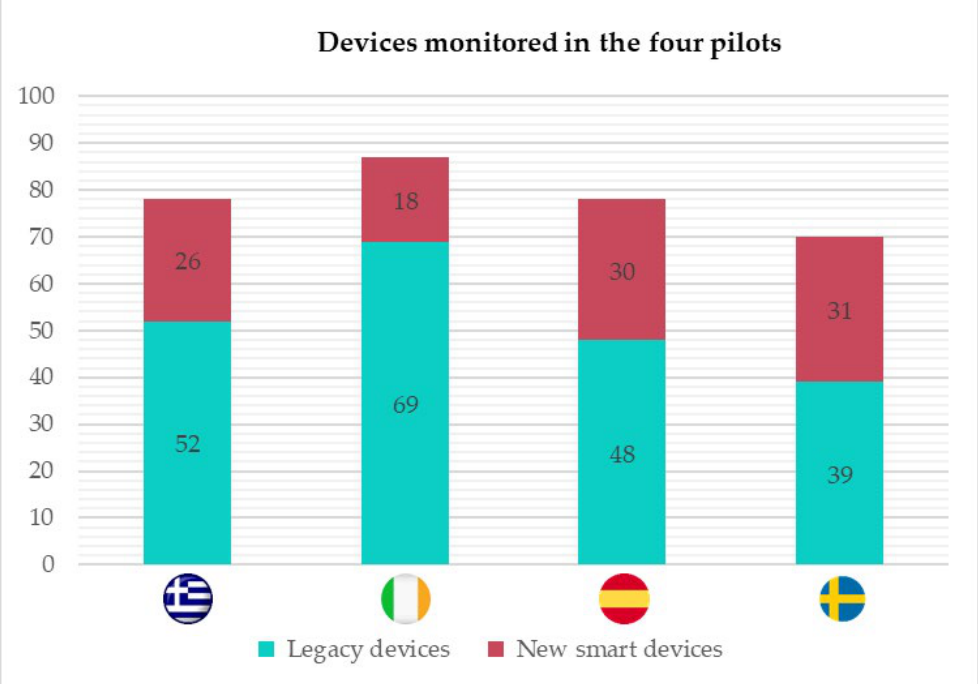
Figure 6. Integrated devices from the four pilots.